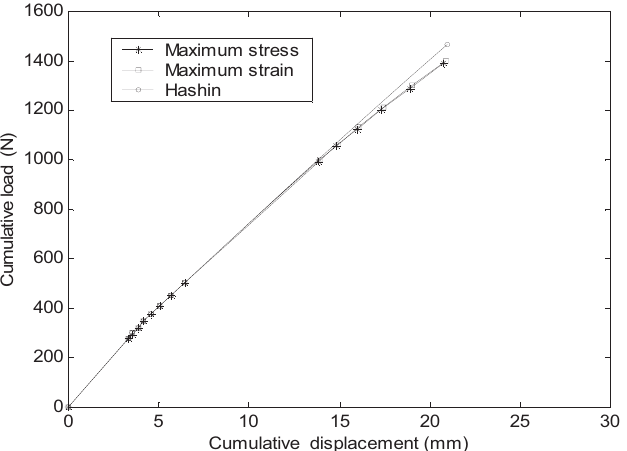
Fig. 2. Cumulative macroscopic curves of the test sample A with the limited discount method (matrix stiffness reduction). Fig. 3. Cumulative macroscopic curves of the test sample